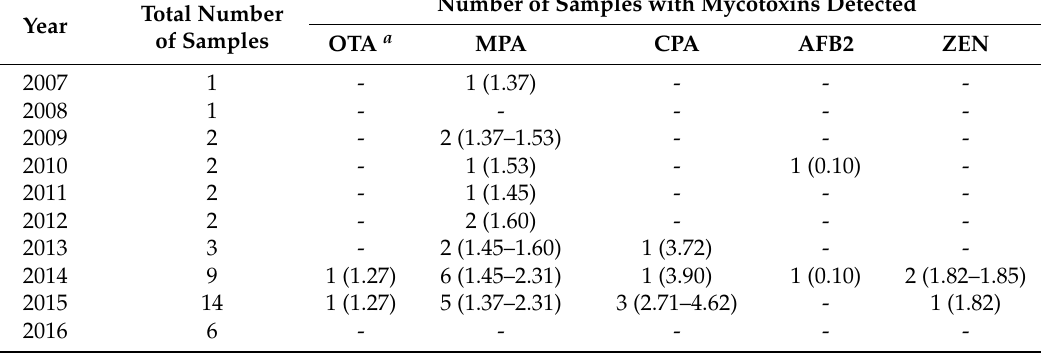
Table 6. Contamination levels of investigated mycotoxins in test wine samples with their frequency of occurrence and concentration ranges ( µ